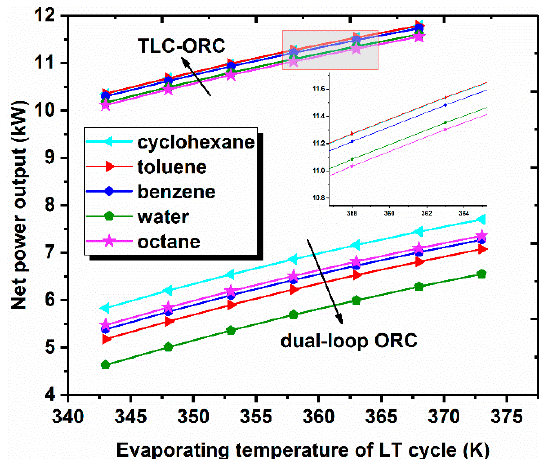
Figure 8. Variation of net power output with T LT,evap under different HT working fluids between two systems.